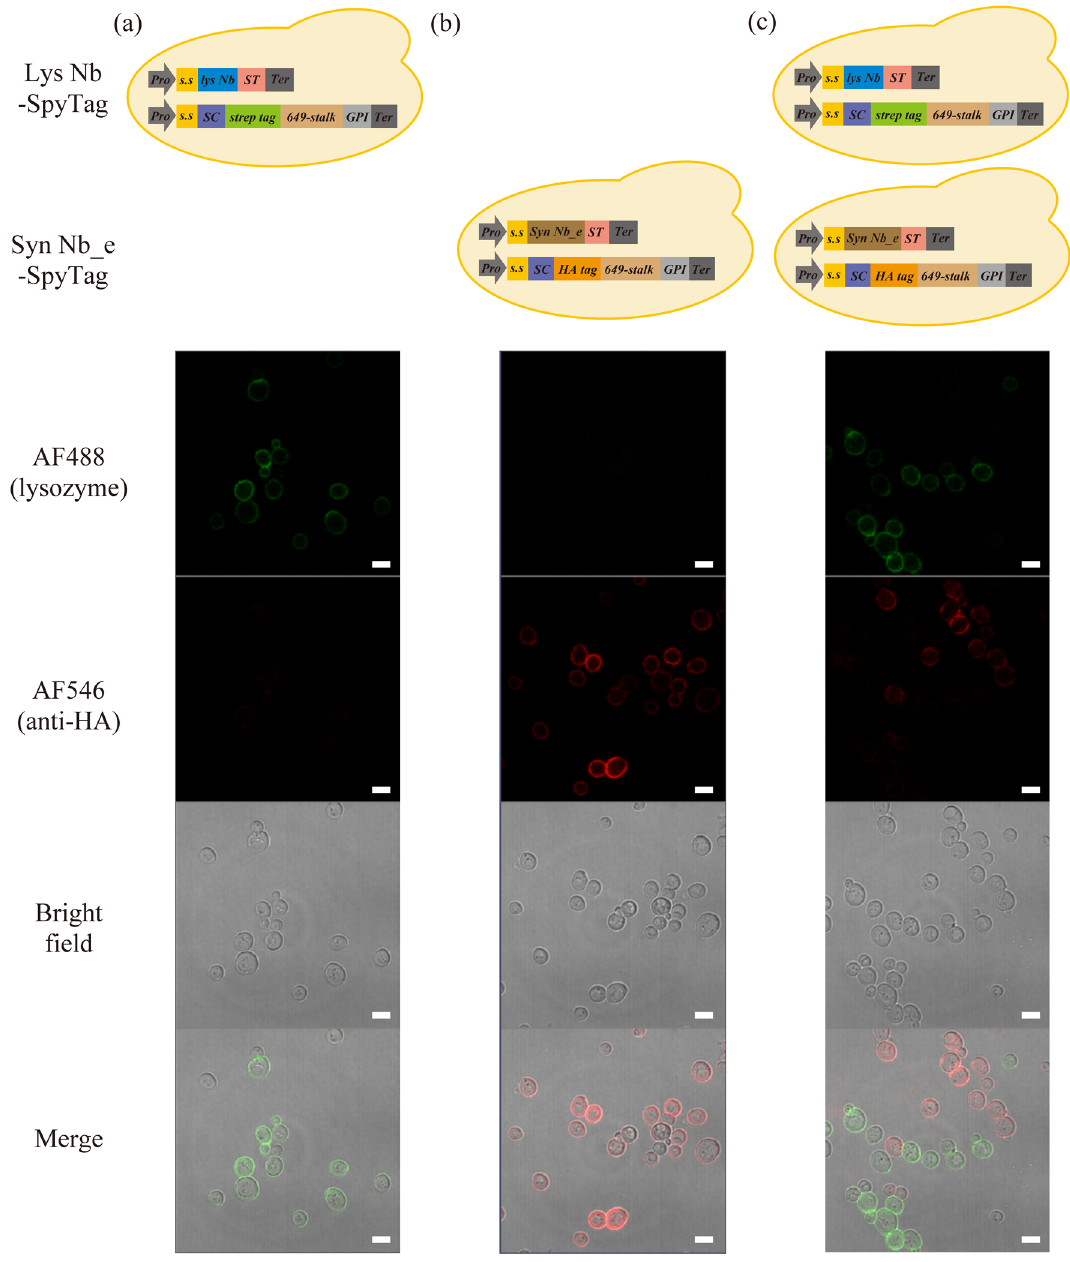
Figure 4. Detection of potential intercellular protein ligation events via microscopy. Yeast cells producing anti- lysozyme nanobody (Lys Nb-SpyTag) (a) or nanobody_e from the synthetic library (Syn Nb_e-SpyTag) (b) were co-cultured (c) to detect for intracellular or intercellular protein ligation between the nanobody-SpyTag and the anchor-SpyCatcher fusion proteins. Each sample was stained with the mouse anti-HA tag antibody, AF546- conjugated anti-mouse antibody and AF488-labelled lysozyme. No AF488- and AF546- both positive cells were detected in co-cultured sample. Pro promoter; s.s secretion signal; SC SpyCatcher; 649-stalk a synthetic anchor protein consisting of 649 amino acids; ST SpyTag; GPI glycosylphosphatidylinositol attachment signal; Ter terminator. Scale bars, 5 µm. This figure was created using Illustrator CS2 (https:// www. adobe.